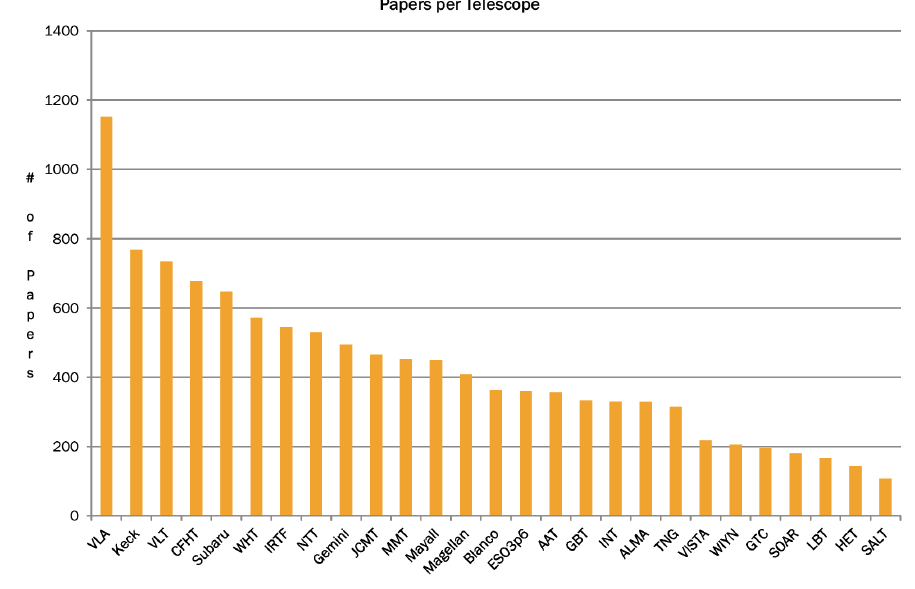
Figure 1. Productivity: Papers per Telescope: 2011 -